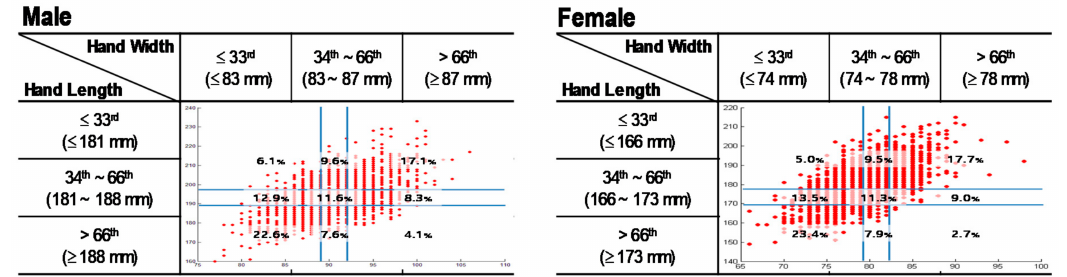
Figure 1. Hand size distribution of participants (28 males and 17 females) by